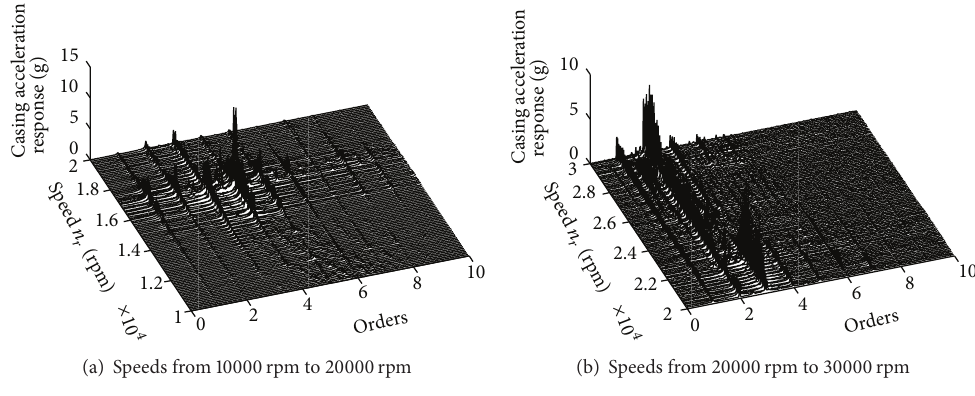
Figure 14: Cascade plot of the casing acceleration response at different